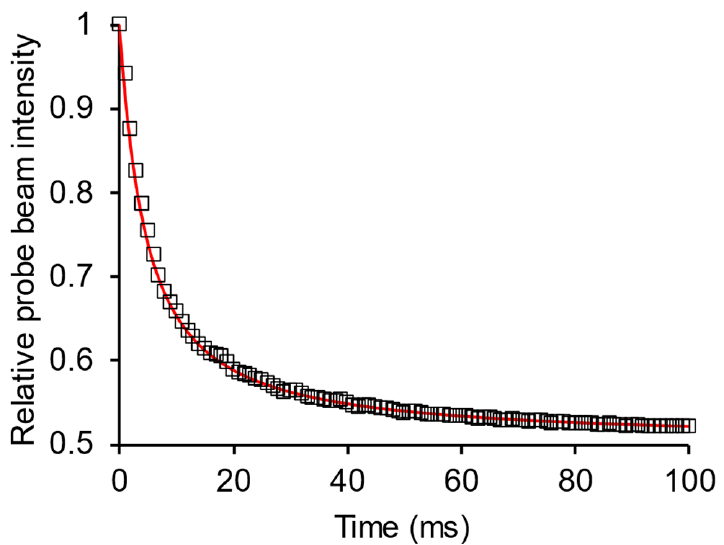
Figure 3. Fit with the theoretical dependence (Equation (2), red curve) for transient thermal-lens data